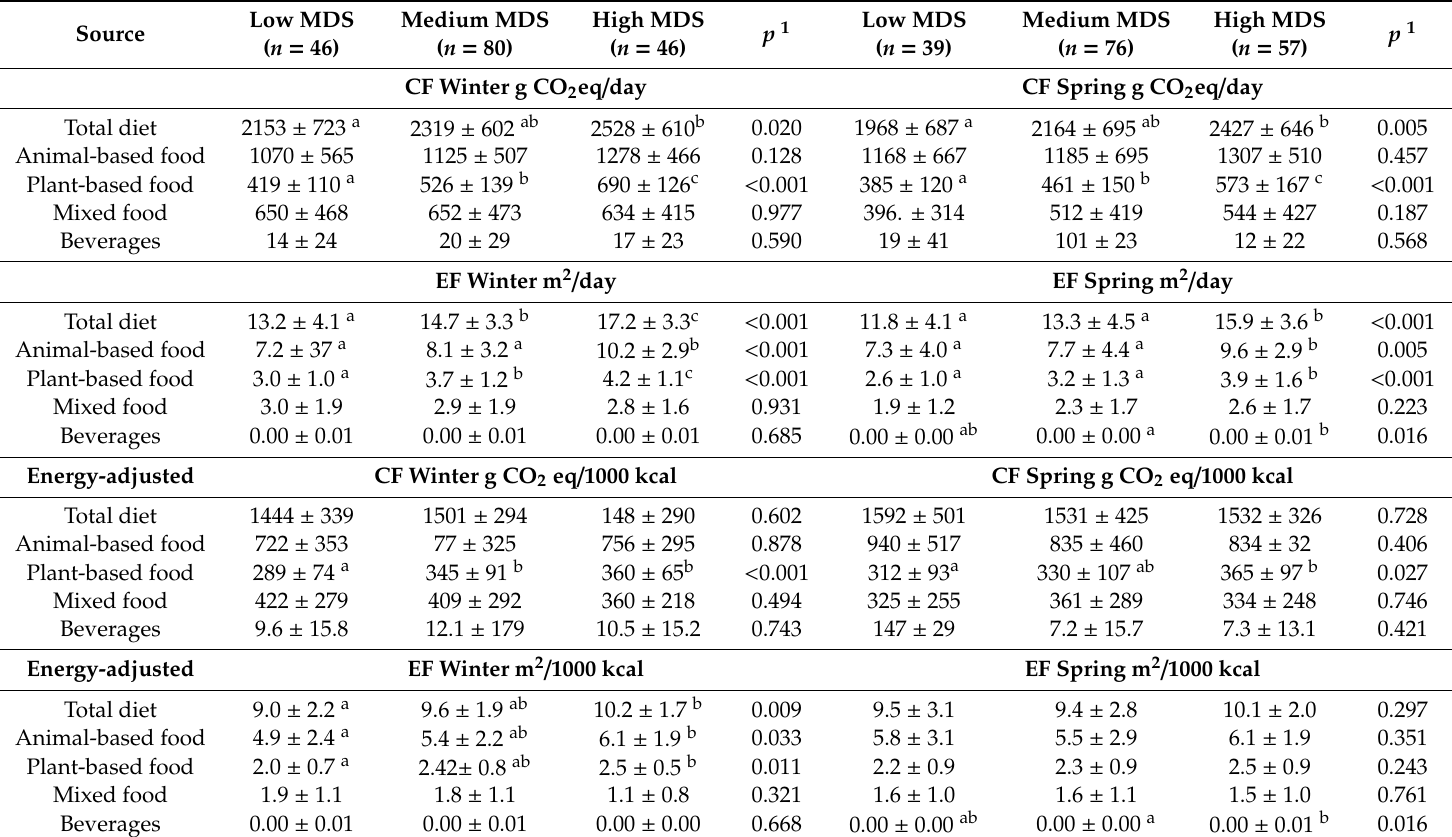
Table 3. Total and food source carbon footprint (CF) and ecological footprint (EF) among adherence to the Mediterranean diet groups by seasons per day and by seasons per 1000